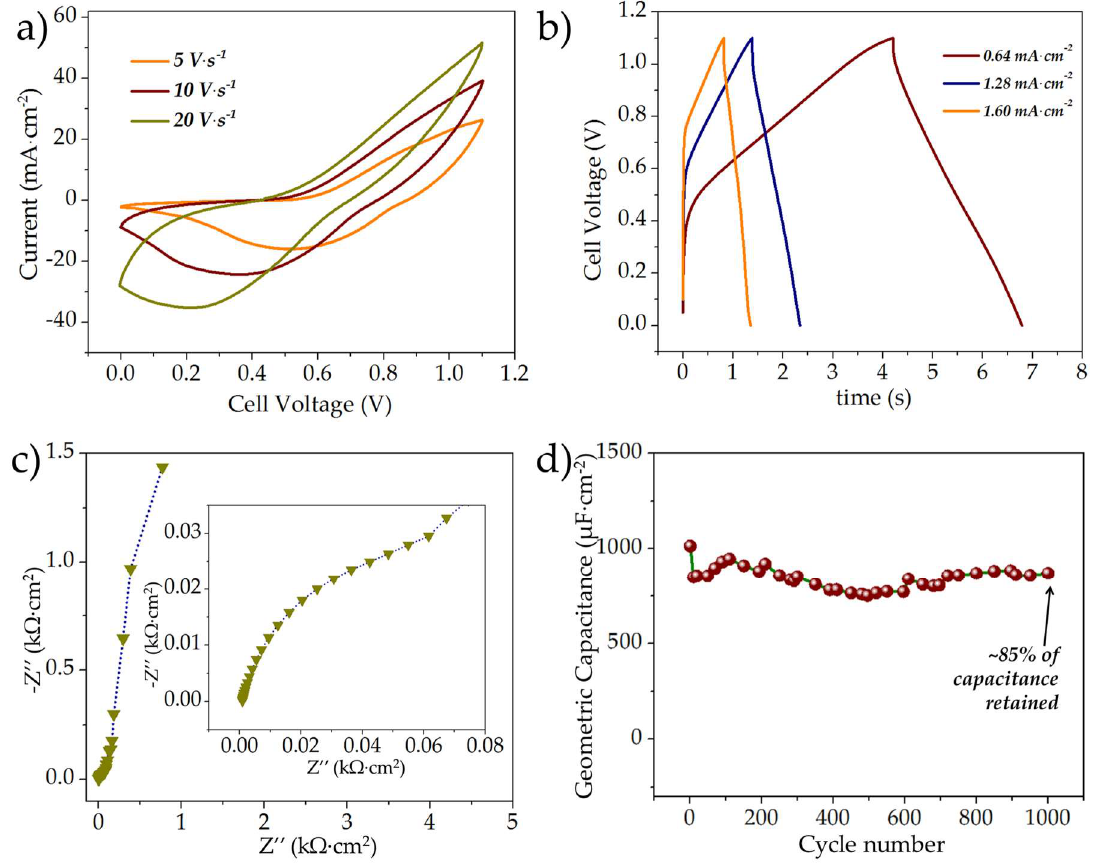
Figure 6. ( a ) Typical CV curves (scanned at 5–20 V·s −1 ); ( b ) GCD curves at different current densities; ( c ) EIS spectra (between 100,000–0.01 Hz) and ( d ) cycle life of the asymmetric rGO//MnO x -0.9C microsupercapacitor.